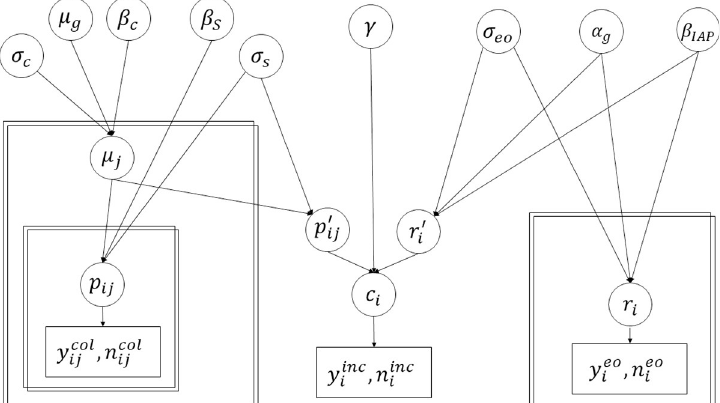
Fig 1. The structures of the hierarchical model on maternal GBS colonization (left) and of the hierarchical model on the risk of early-onset iGBS disease in babies born to colonized mothers (right) are shown. The component of the full model that uses data on early-onset iGBS disease incidence as well as functions of parameters estimated in the two first components is presented in the middle. Eqs 1 – 8 in the text describe model parameters and distributional assumptions. Circles represent parameters; rectangles with single border, in the lower part of the figure, correspond to observations and rectangles with double borders represent the hierarchical structure of the data.